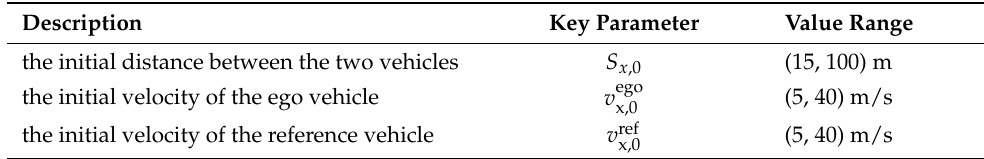
Table 2. Parameter settings for the simplified car-following scenario.